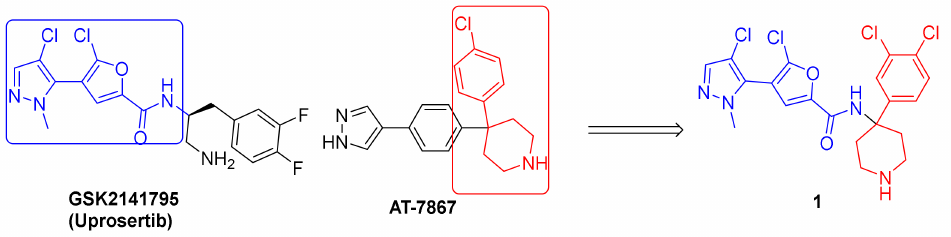
Figure 3. Structures of G-SK2141795 and AT-7867 and the hybridization to yield compound 1 .